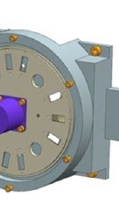
Figure 5. Structure diagram of turntable